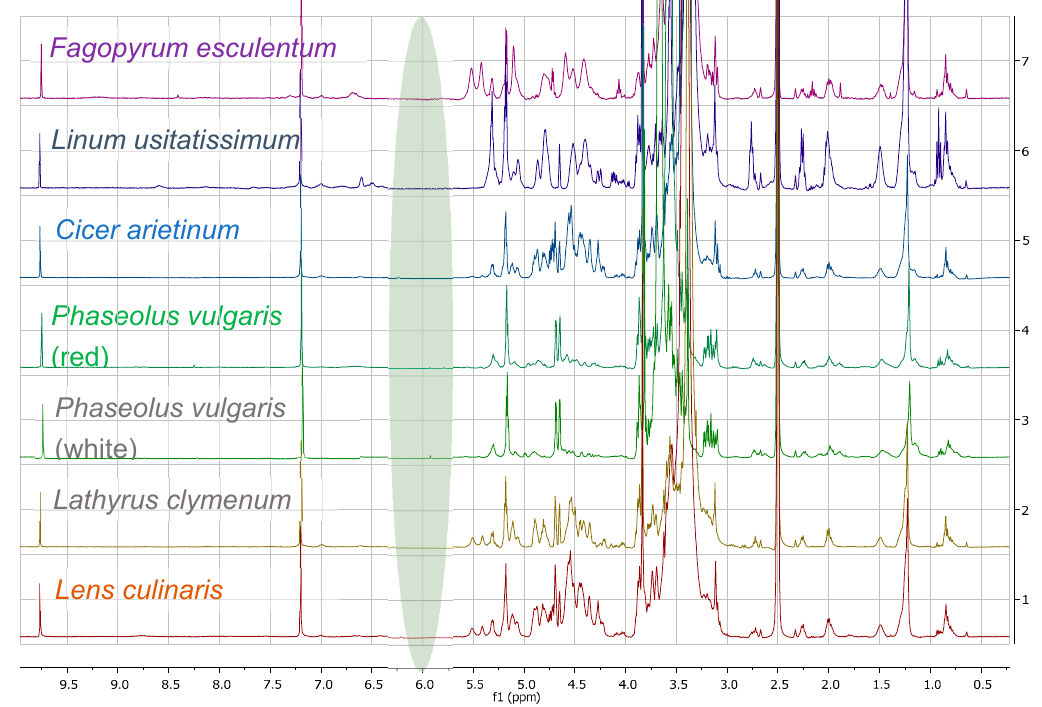
Foods 2020 , 9 , x FOR PEER REVIEW Figure A3. NMR spectra in DMSO from seeds and beans without ARS. Figure A3. NMR spectra in DMSO from seeds and beans without ARS.